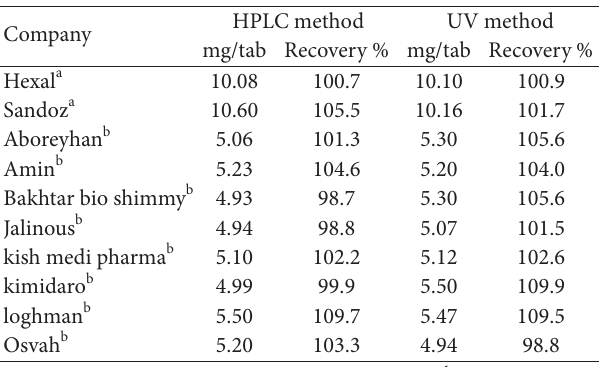
T 3: Results of the data analysis for the quantitative determina- tion of zolpidem by the proposed method.